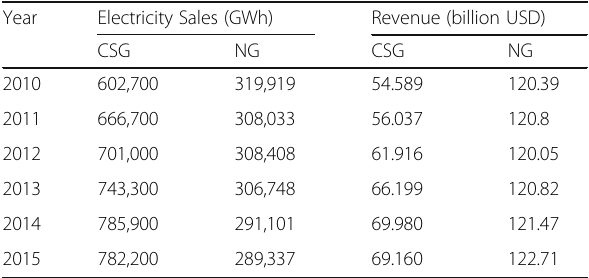
Table 4 Electricity sales of CSG and